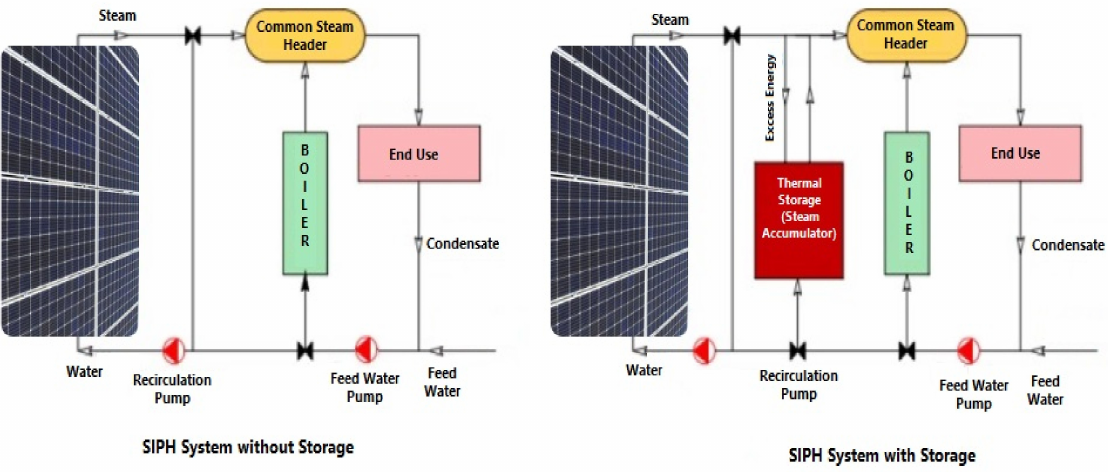
Figure 1. SIPH systems (PTC) used for the present study. Table 4. Calculated values of thermal energy storage (TES) with corresponding solar fraction (SF) of PTC at DNI d = 600 W/m 2